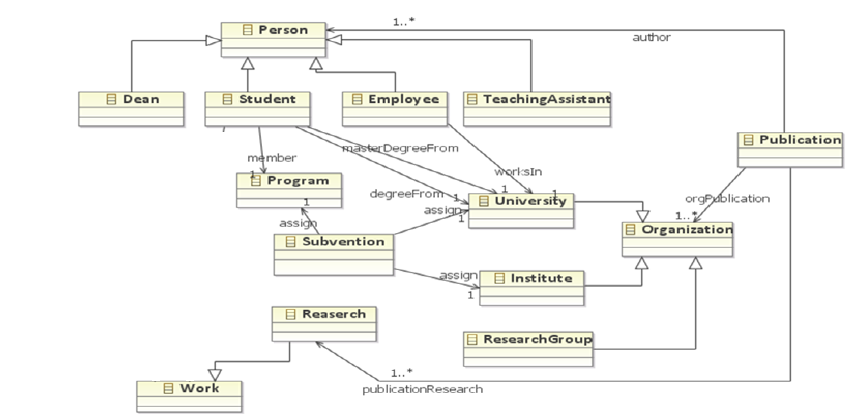
Figure 6. DWO schema (Lehigh University BenchMark, LUBM).